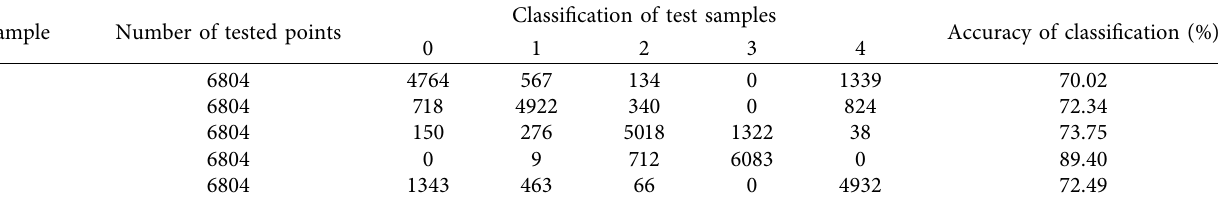
Table 1: Classification results of NB model.